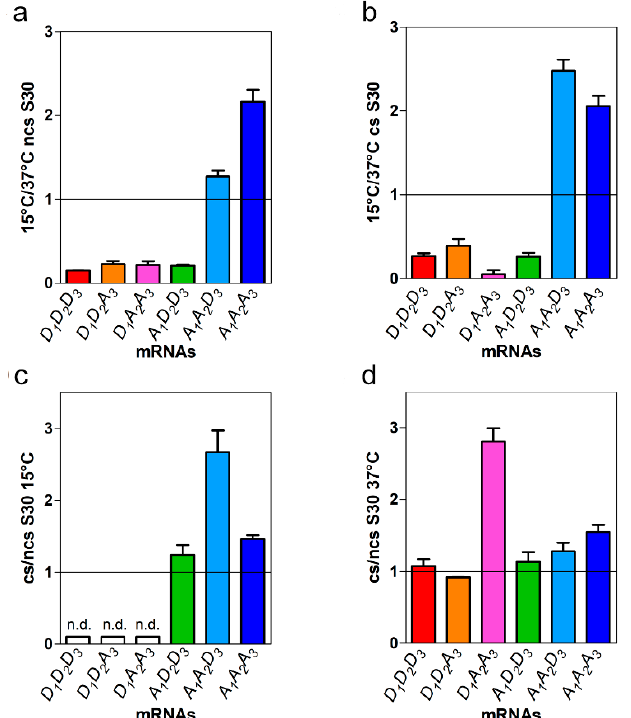
Figure 3. Relative levels of translation recorded for the various mRNAs as a function of temperature in the presence of the extracts of control and cold shocked cells. The histograms indicate the ratio of the translational level obtained with the mRNAs indicated in the abscissa at ( a , b ) 15 and 37 °C in the presence of extracts of control ( a ) and ( b ) cold-shocked cells. The ratios of the translational level obtained with the indicated mRNAs in cold shock and control cell extracts at ( c ) 15 °C and ( d ) 37 °C. Each histogram represents the average ratio calculated from a duplicate; error bars indicate the standard deviation. n.d.=not detected.